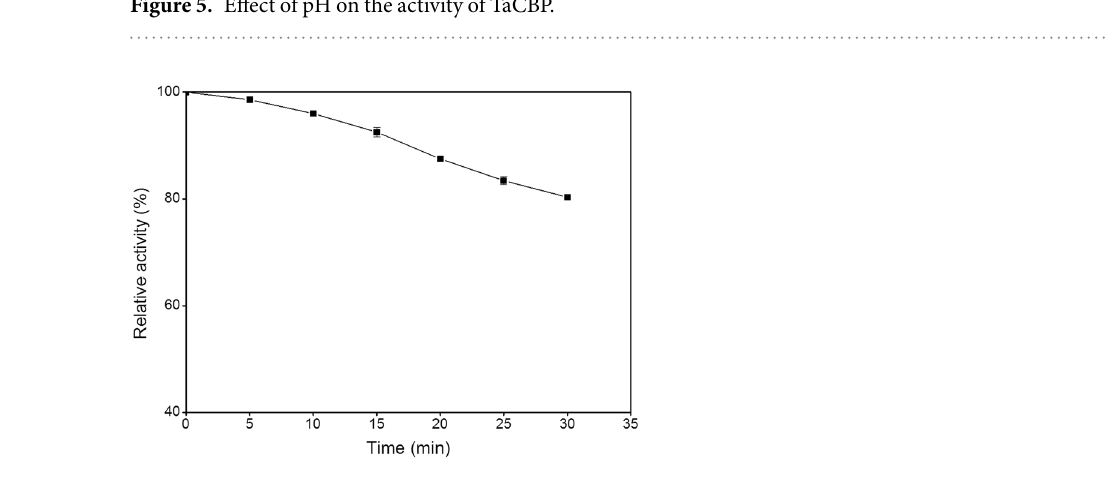
Figure 6. The stability of TaCBP incubated at 75 °C.